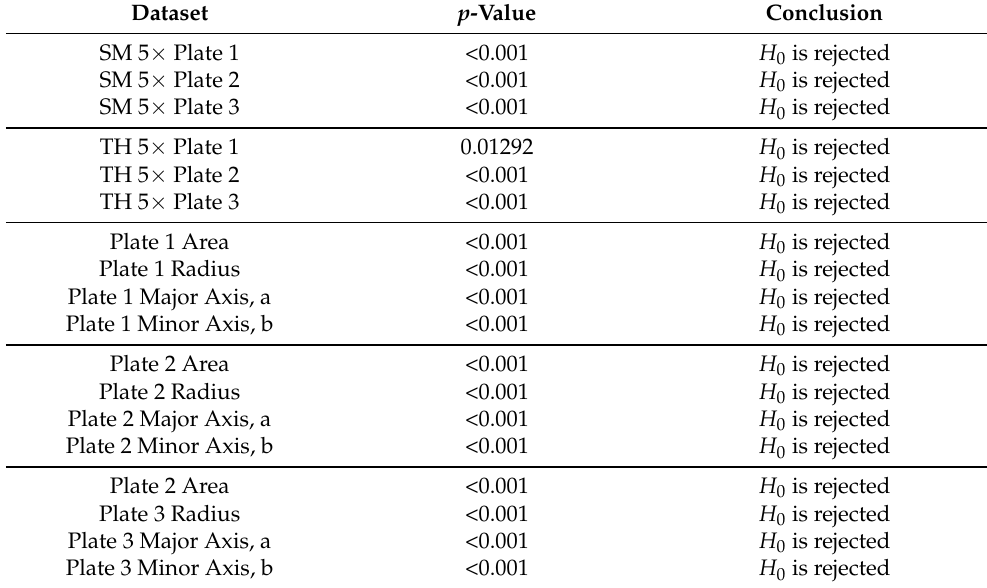
Table A1. Results for the Shapiro–Wilk